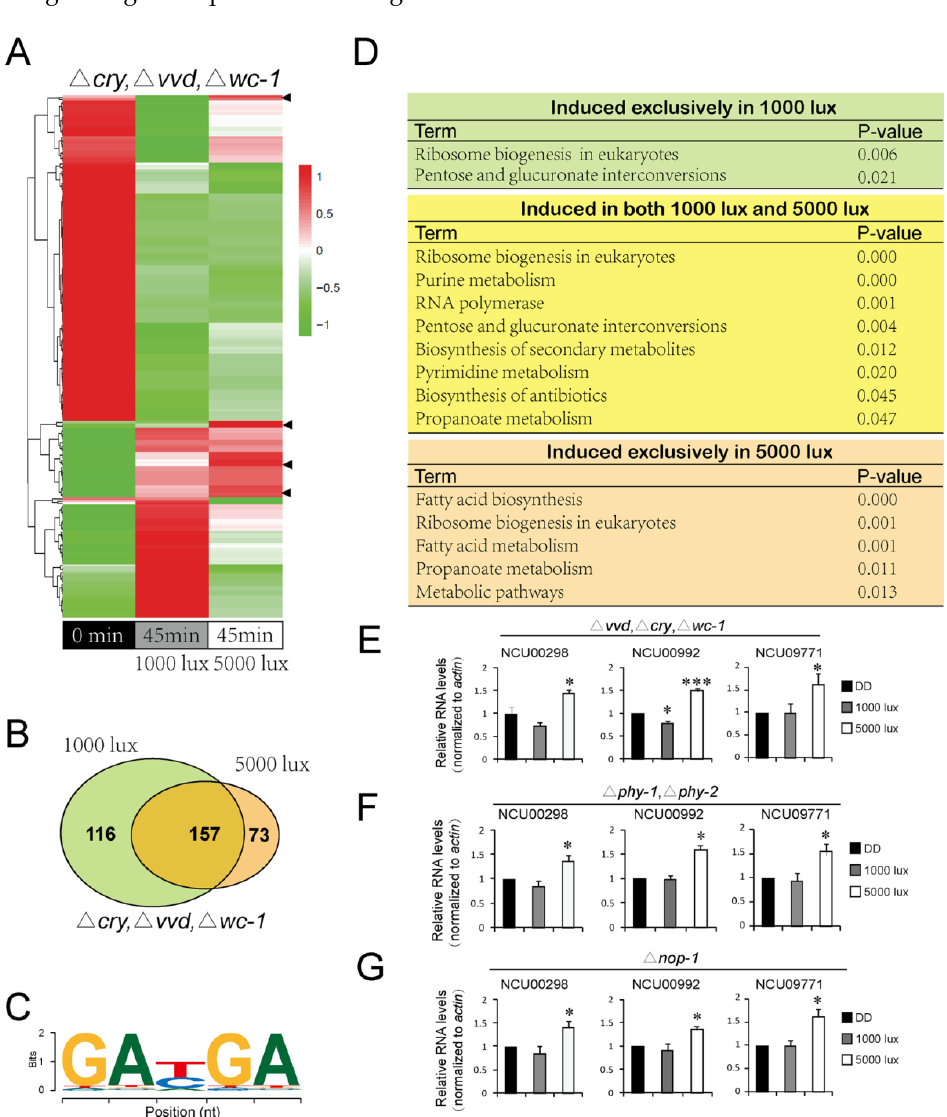
Figure 6. Characterization of genes showing light responses in high-intensity white light. ( A ) Heat map of the differentially expressed genes in ∆ vvd , ∆ cry , ∆ wc-1 at DD24, 1000-lux white light and 5000-lux white light. “0 min” refers to the sampling time prior to light exposure, “45 min” refers to the sampling time point of 45 min after light exposure. The heat map was created according to the RNA-seq data, ( B ) Venn diagram showing the genes up-regulated in 1000 lux and 5000 lux relative to DD24, respectively, ( C ) sequence logo of a predicted motif, ( D ) distribution of affected KEGG pathways according to the up-regulated genes revealed from RNA-seq, ( E – G ) qRT-PCR validation of three genes specifically induced by 5000-lux light in ∆ vvd , ∆ cry , ∆ wc-1 ( E ), ∆ phy-1 , ∆ phy-2 ( F ) and ∆ nop-1 ( G ) strains. The gene expression was normalized to actin . The levels at DD24 were normalized to 1.0. Data are mean ± SE, n = 3. * represents p ≤ 0.05 and *** represents p ≤